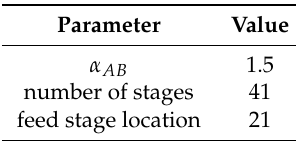
Table 2. Distillation Column A